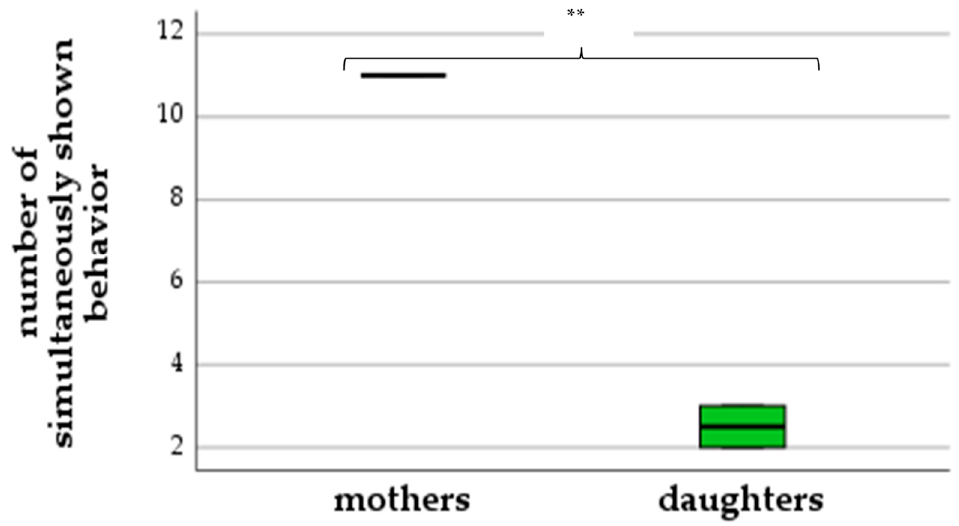
Figure 2. Number of simultaneously shown behaviors (differences between mothers and daughters) (* p < 0.05; ** p < 0.01).